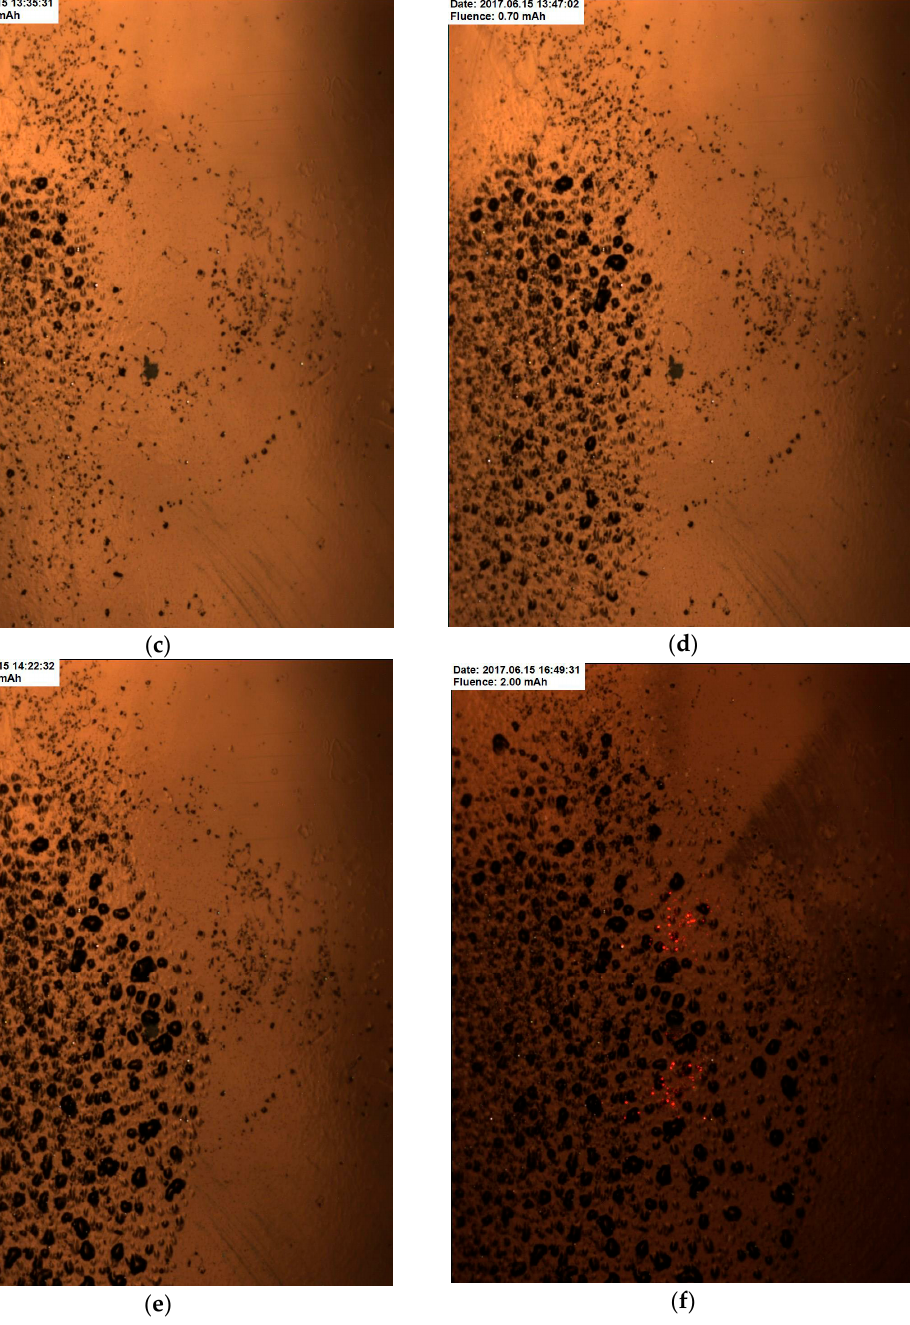
Figure 15. Images of the surface of 99.99996% coarse-grained copper (Sample 3) during irradiation by a 2-MeV proton beam with varying integrals of the current: ( a ) 0.02, ( b ) 0.10, ( c ) 0.59, ( d ) 0.70, ( e ) 1.00, ( f ) 2.00 mA·h. The frame size is 12 × 12 mm 2 .